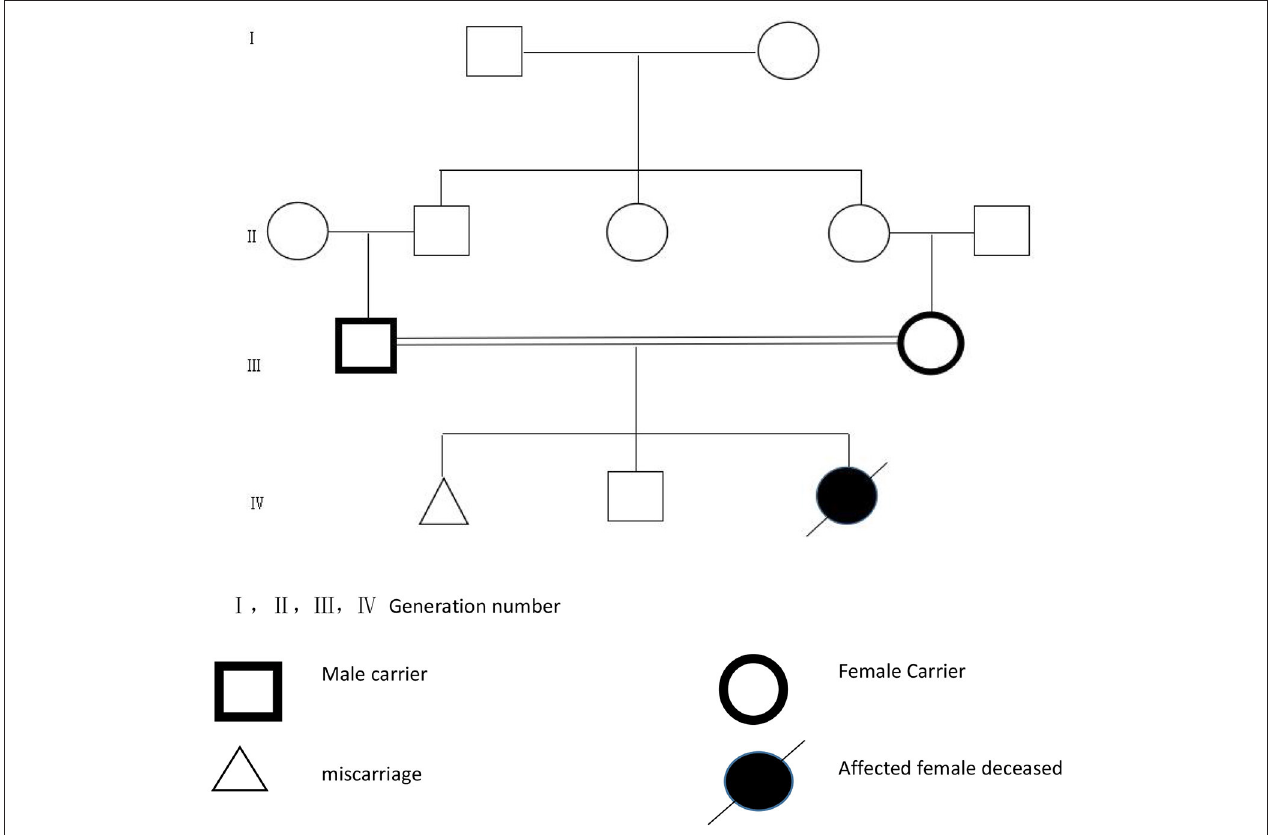
FIGURE 1 | The pedigree.